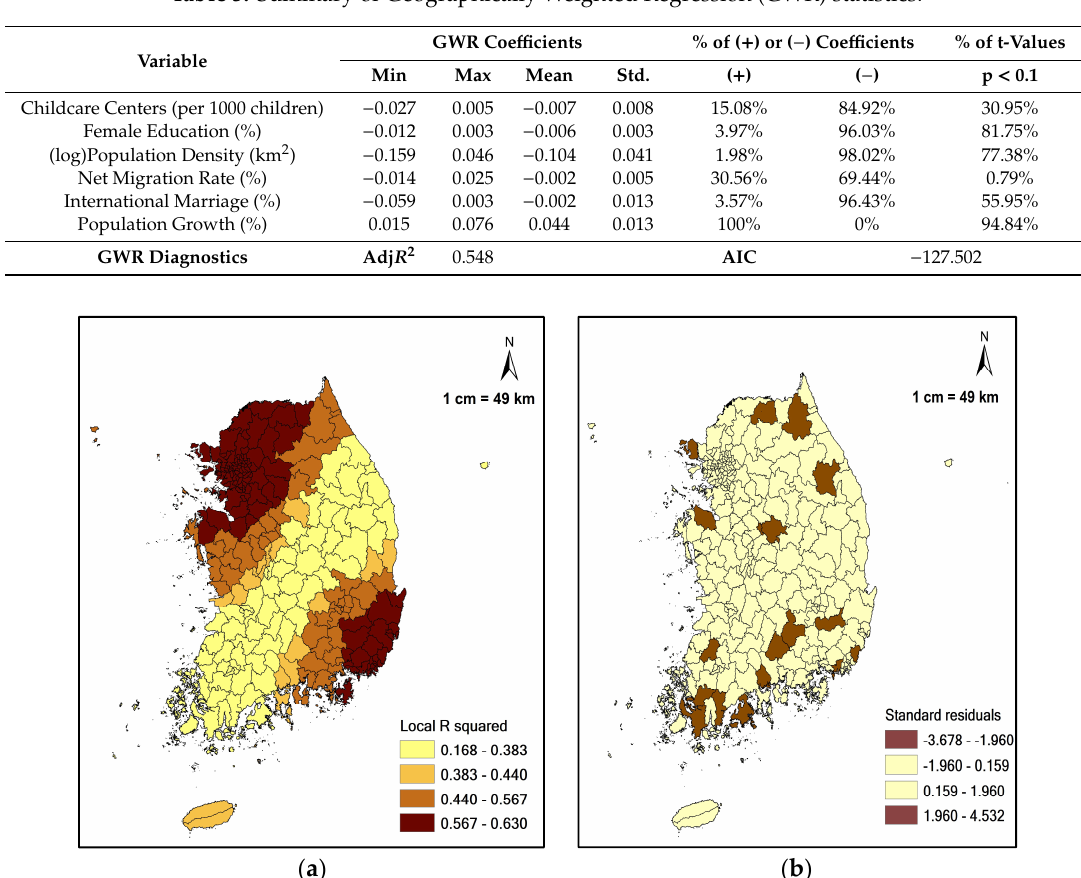
Table 3. Summary of Geographically Weighted Regression (GWR) statistics.